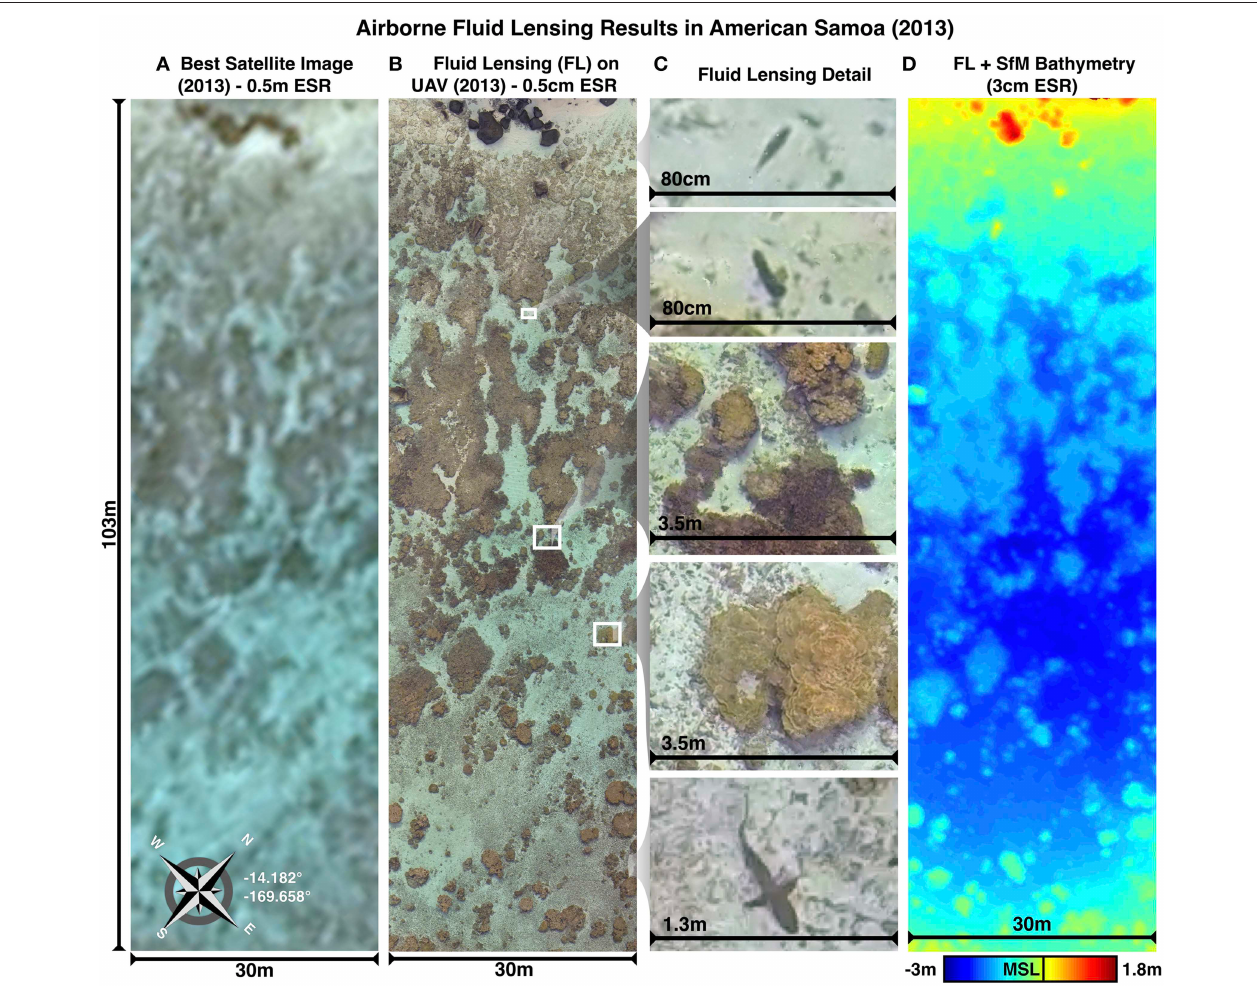
FIGURE 6 | The first airborne fluid lensing results from an experimental 2013 campaign in American Samoa. (A) Highest-resolution publicly available image of a transect area captured June 2015 from Pleiades-1A satellite with 0.5m ESR. (B) Fluid lensing 2D result of the same area as captured from UAV at 23m altitude with estimated 0.5–3cm ESR. (C) Inset details in fluid lensing 2D image include a parrotfish including Porites and Acropora, and a reef shark. (D) High-resolution bathymetry model generated with fluid lensing caustic bathymetry (FL) and Structure from Motion (SfM) algorithms, validated by underwater photogrammetry. Maximum depth in model is Chirayath